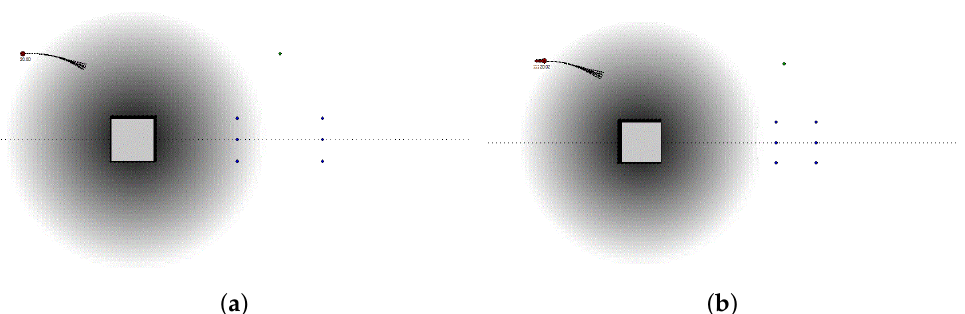
Figure 7. Obstacle avoidance example 2: Moving object represented in contiguous time frames. The two grid maps ( a , b ) belong to two consecutive path-planner runs. Figure 7a represent the environment at T = T 0 , and Figure 7b at T = T 0 + 20 ms.